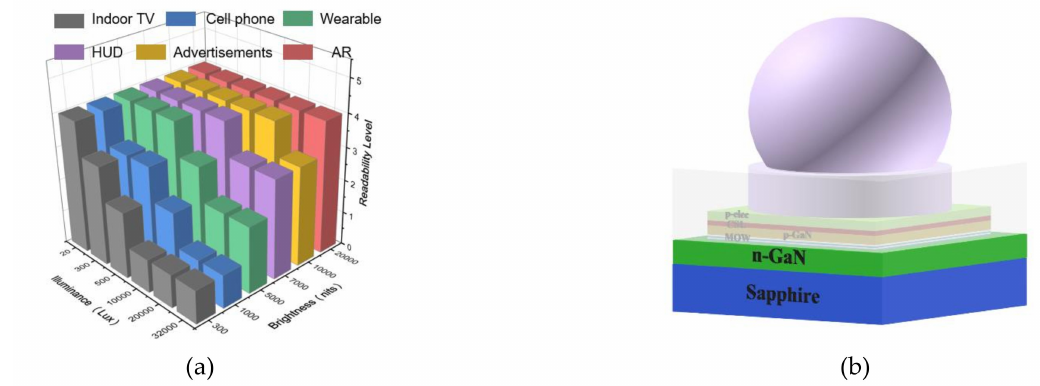
Figure 3. ( a ) ACR level comparison of potential outdoor products under different operation situations. ( b ) Three- dimensional structure of a micro-LED